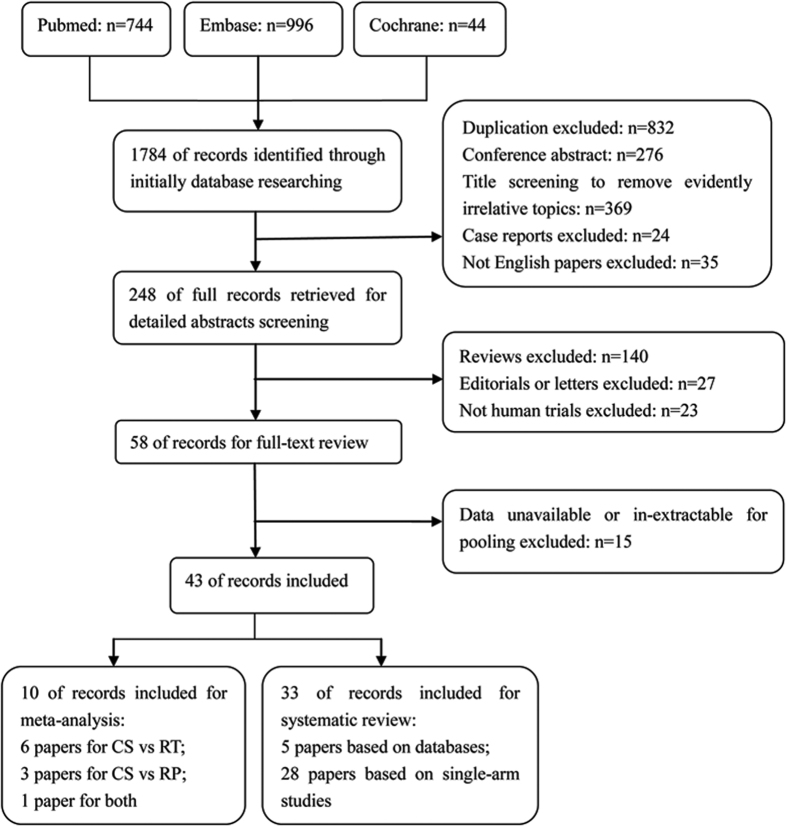
Data flow chart of meta-analysis.CS = cryosurgery; RT = radiotherapy; Rp = radical prostatectomy.